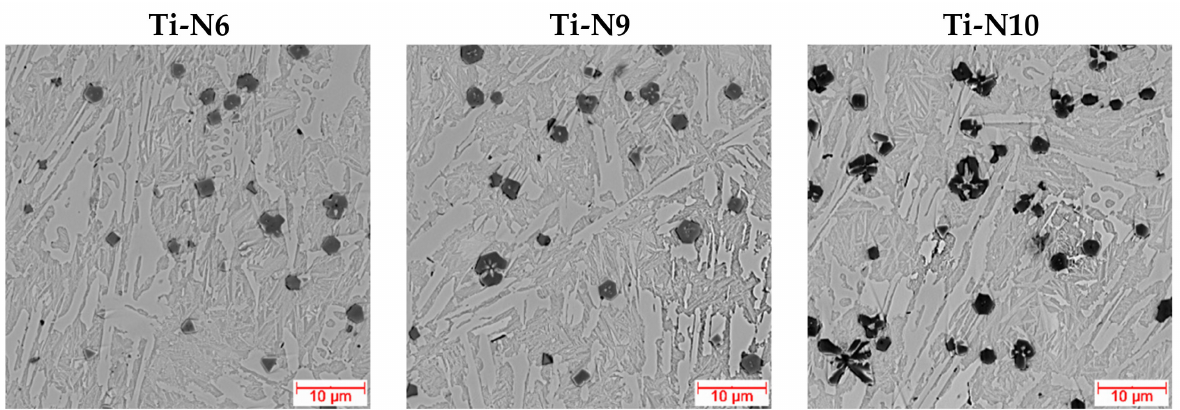
Figure 5. The microstructure of homogeneous laser-alloyed surface layers (designation according to Table 3).